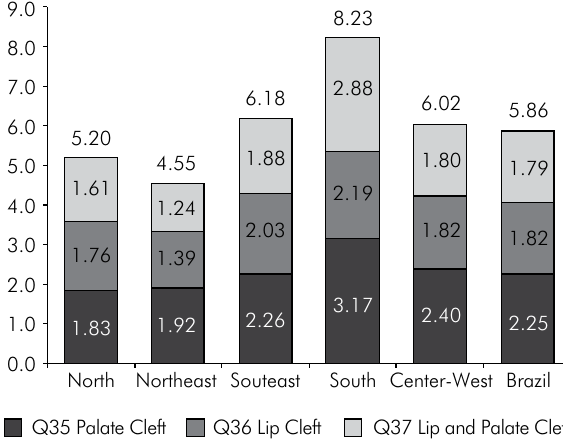
Figure 1. Orofacial cleft prevalence per 10,000 live births, according to region and type of malformation, in Brazil from 2009 to 2013.